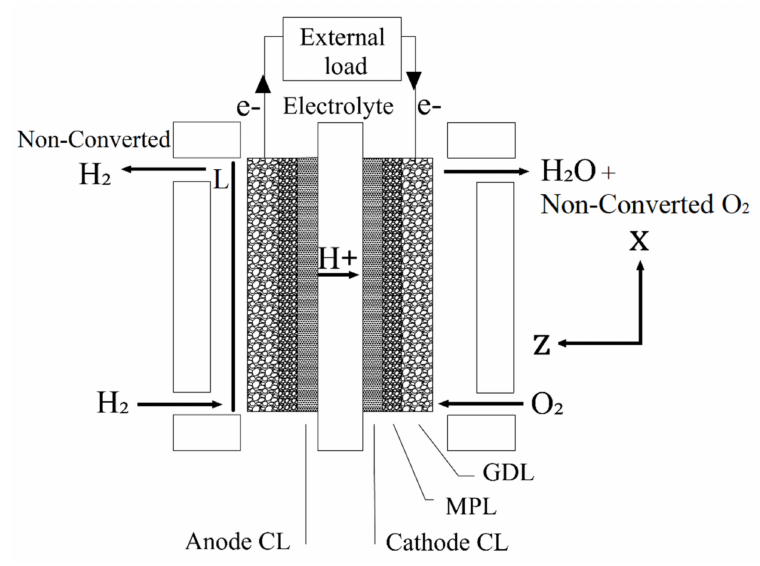
Figure 4. Schematic of PEMFC working principles and